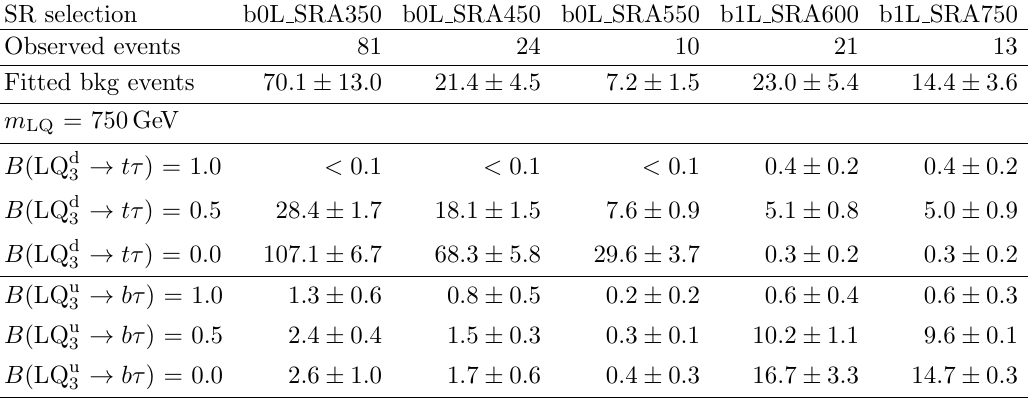
Table 7 . Number of observed events and background-only (cid:12)t results in the SRs. The uncertainties contain both the statistical and systematic uncertainties. Two example LQ signal samples are also shown for comparison, with various assumptions about B (LQ ! q(cid:28) ).